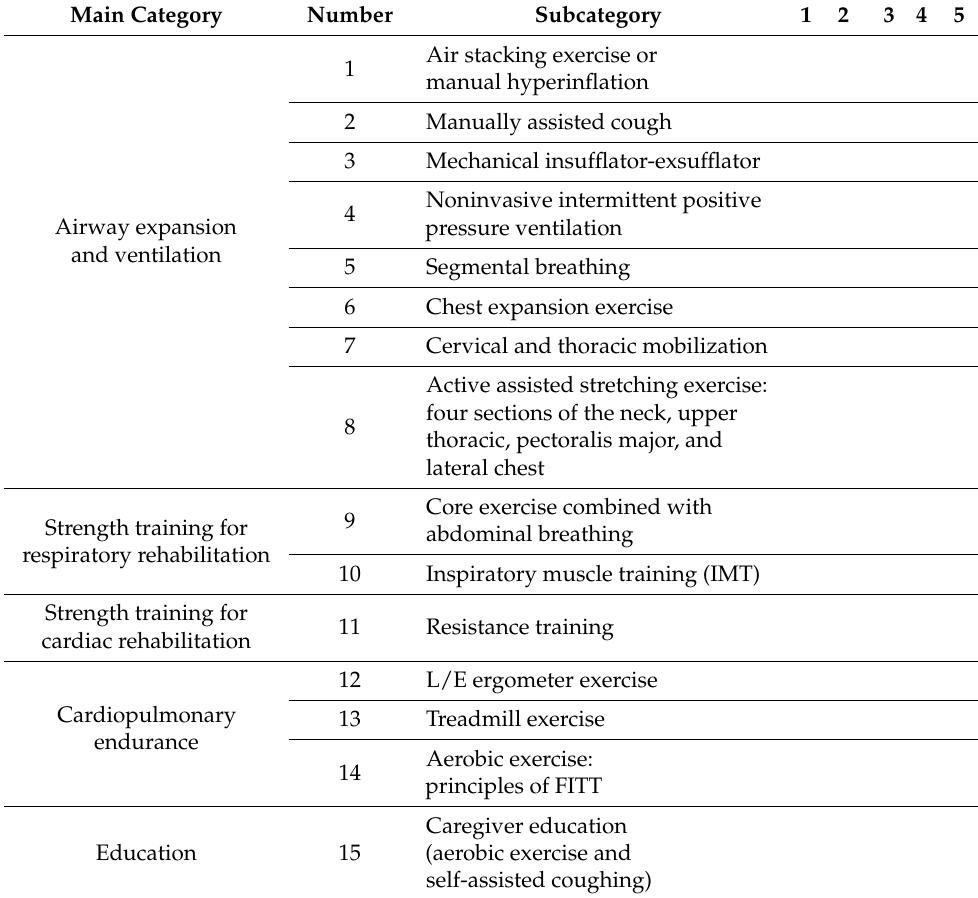
Table A2. Cardiorespiratory fitness interventions for stroke patients (second modified Delphi tech- nique). Please select the appropriate answer for each